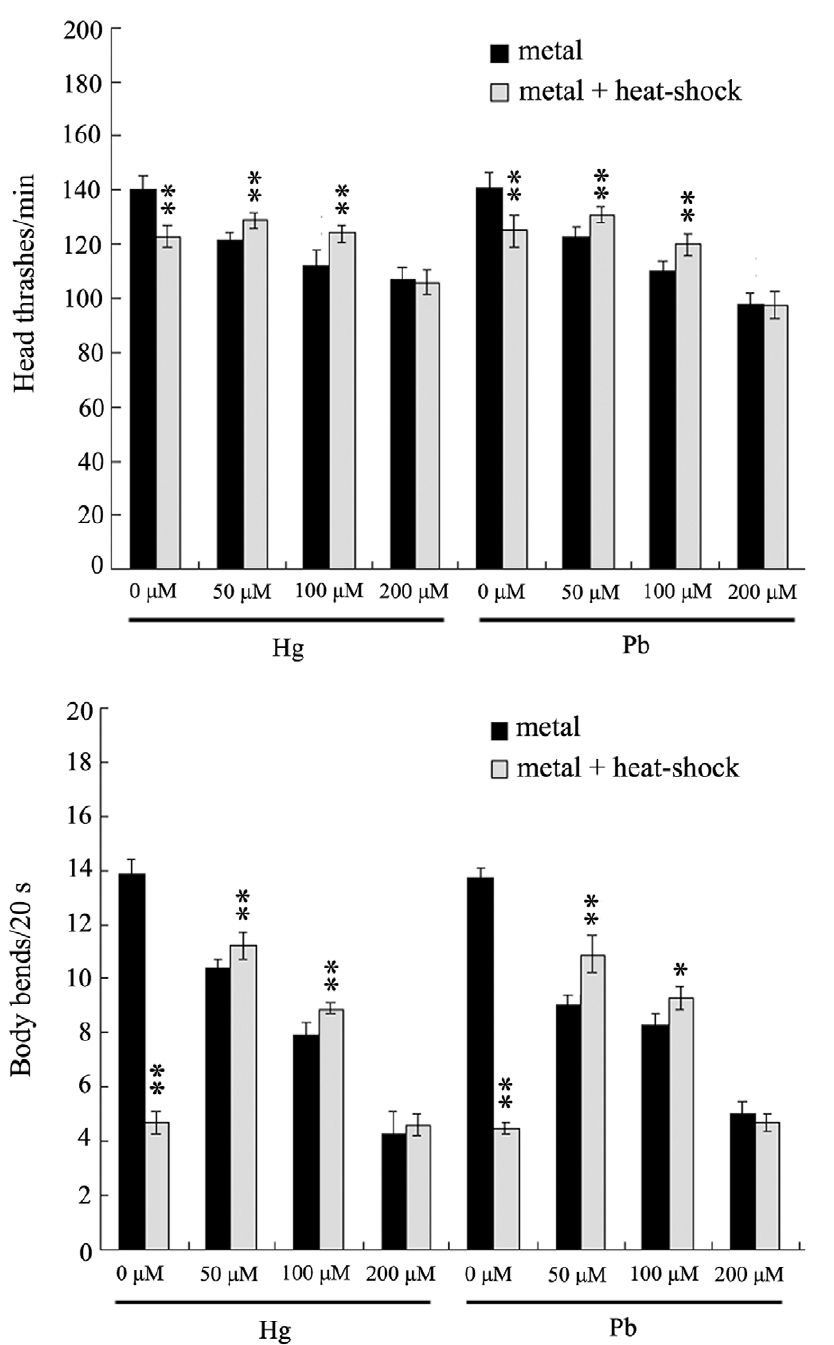
Figure 3. Effects of pre-treatment with mild heat-shock on neurobehavioral toxicity induced by metal exposure in wild-type N2 nematodes. L2-stage larvae animals were heat stressed for 1 h at 36 u C. The exposed metal concentrations were 50, 100, and 200 m M. Bars represent means 6 S.D. * p , 0.05 vs metal; ** p , 0.01 vs metal. doi:10.1371/journal.pone.0014052.g003 P mtl-2 ::GFP, were constructed to have GFP protein fused to the P mtl-2 ::GFP transgenic strains. In contrast to these, after mild promoters of mtl-1 and mtl-2 , respectively. As shown in Fig. 5A, the heat-shock treatment at the L2-larval stage, the GFP signals were GFP signal was nearly undetectable in control animals. The mild sharply increased in 50 m M or 100 m M of Pb exposed P mtl-1 ::GFP heat-shock treatment induced the moderate but significant and P mtl-2 ::GFP transgenic adult animals compared with those increase of GFP signals in P mtl-1 ::GFP and P mtl-2 ::GFP treated with mild heat-shock or Pb exposure alone. We have transgenic strains. Exposure to 50 m M and 100 m M of Pb obtained 5 lines of P mtl-1 ::GFP and 7 lines of P mtl-2 ::GFP transgenic nematodes, and all showed the similar phenotypes (data induced the slight increase of GFP signals in P mtl-1 ::GFP and